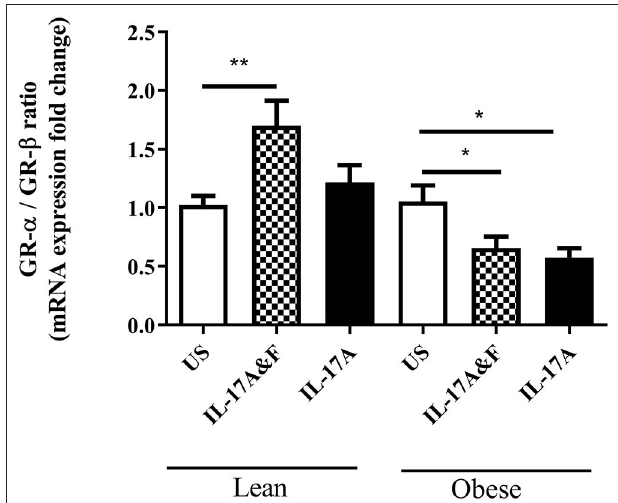
FIGURE 1 | Stimulation with IL-17A & F and IL-17A alone induces changes in GR- α /GR- β mRNA ratio. Adipocytes from lean and obese subjects were stimulated with 100ng/mL of IL-17A and IL-17F in combination or IL-17A alone for 48h. Cells were collected and qRT-PCR analysis was performed in duplicate using TaqMan probes to assess GR- α and GR- β mRNA expression. One independent experiment performed per subject. n = 4 lean subjects, n = 3 obese subjects, One-Way ANOVA, Mean ± SE; * P < 0.05, ** P <